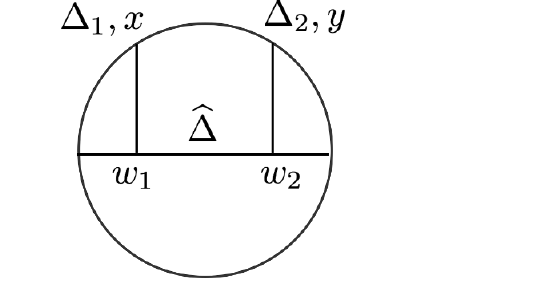
Figure 5. A boundary channel exchange Witten diagram W boundary in the probe brane